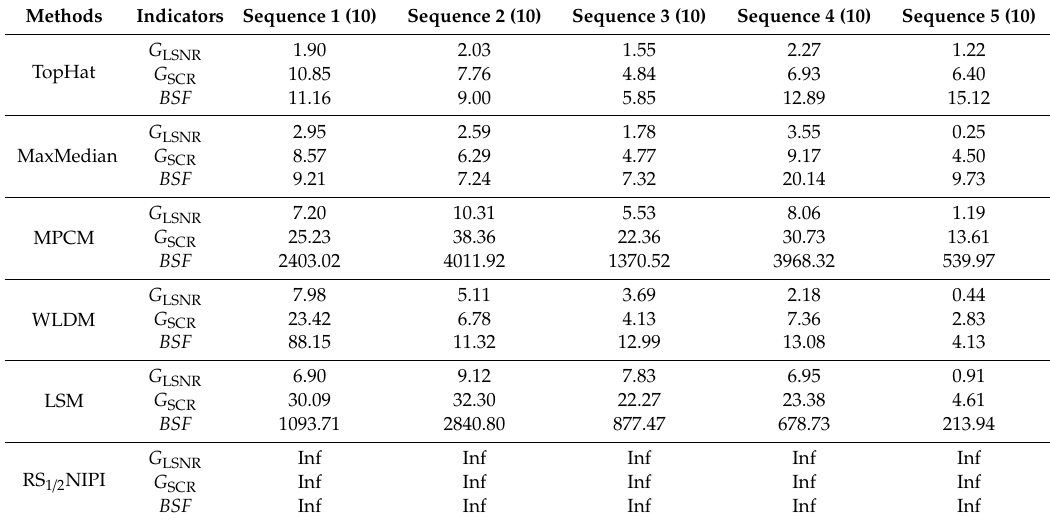
Table 5. Quantitative indicators of the di ff erent methods in term of G LSNR , G SCR and BSF.